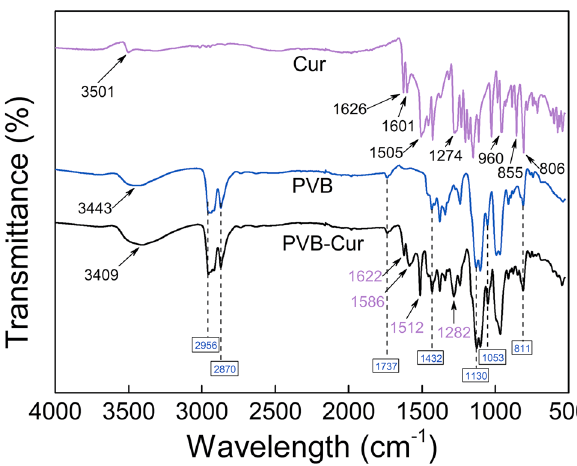
Figure 2: FTIR spectra of Cur, PVB, and PVB – Cur fi lm.